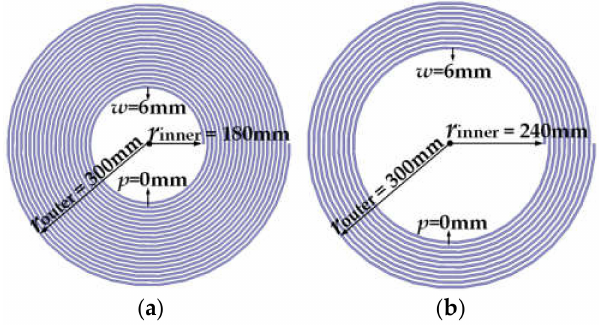
Figure 9. Inner radius and coil turns changing: ( a ) 20 turns; ( b ) 10 turns.